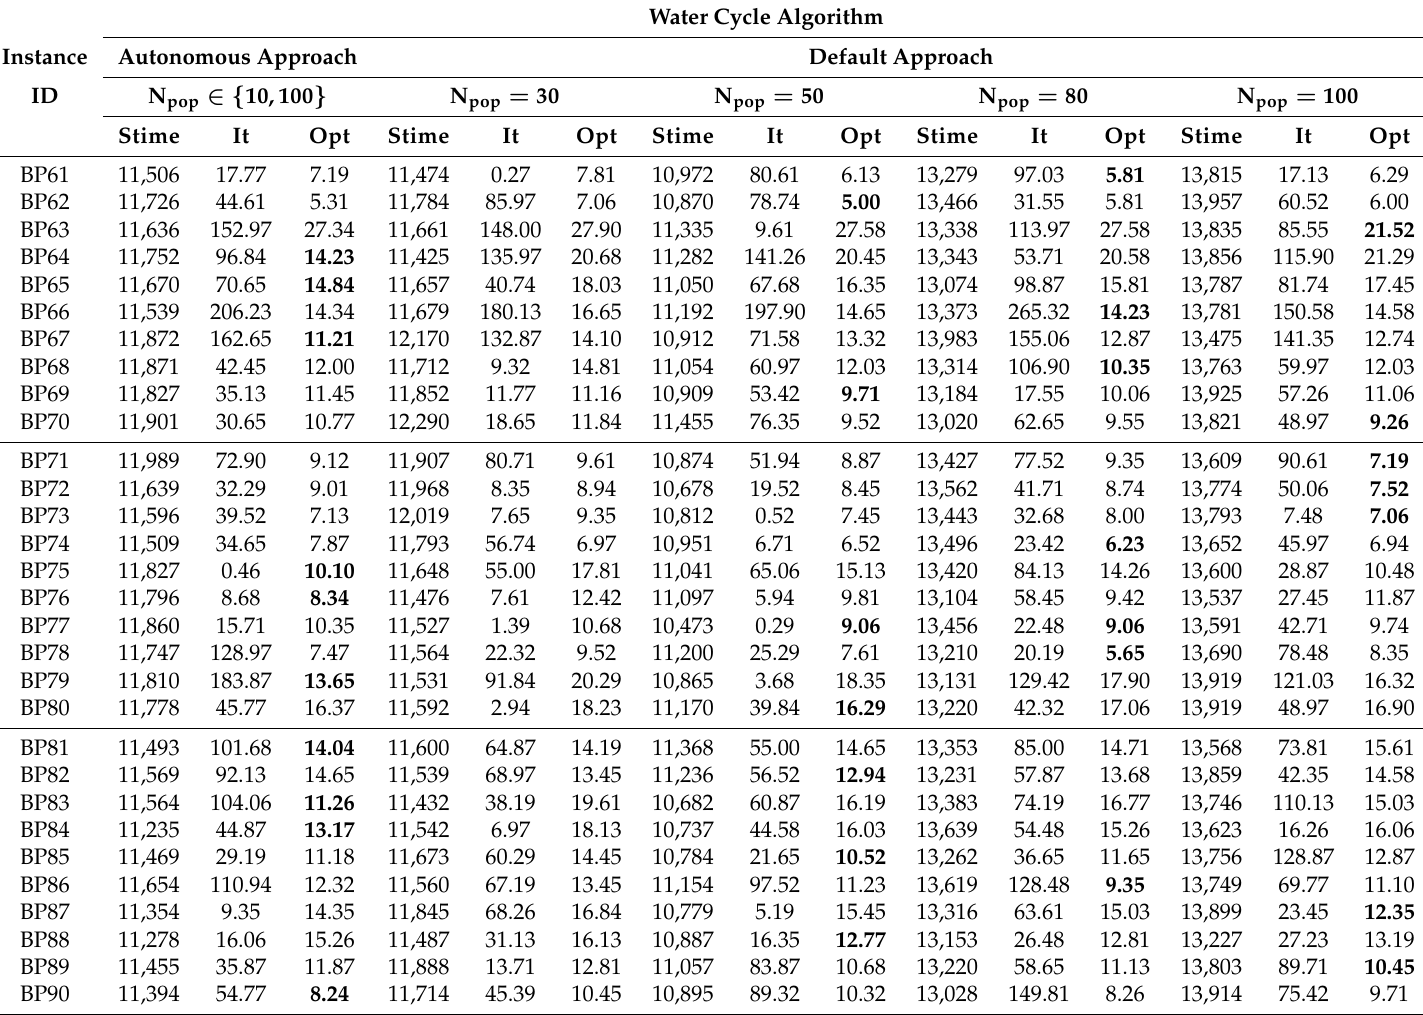
Table 8. Results solving the Boctor’s instances (3/3). Water Cycle